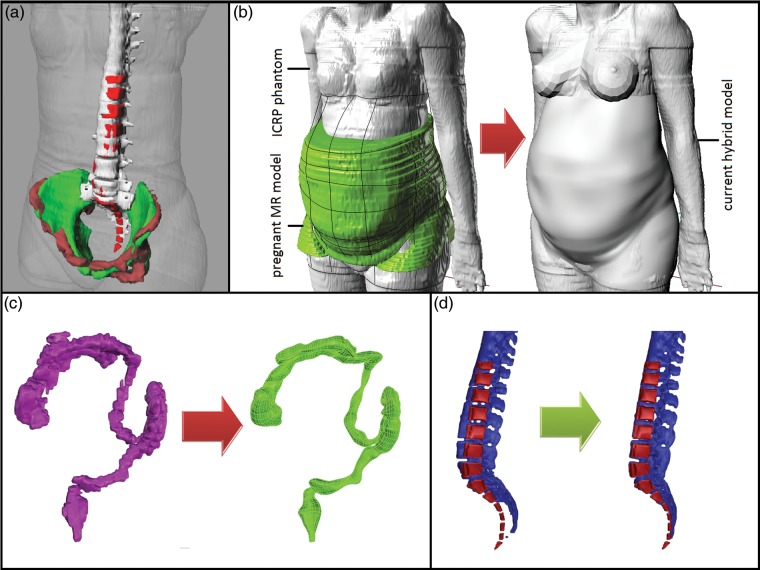
(a) Orientation of segmented structures (red) to the polygon mesh version of the adult female ICRP reference voxel phantom (green and gray) guided by the location of bones. (b, c) Creation of NURBS surface using ‘curve network’ tool. (d) Before (left) and after (right) orienting and aligning AF spine (blue) to the segmented spine landmark (red).